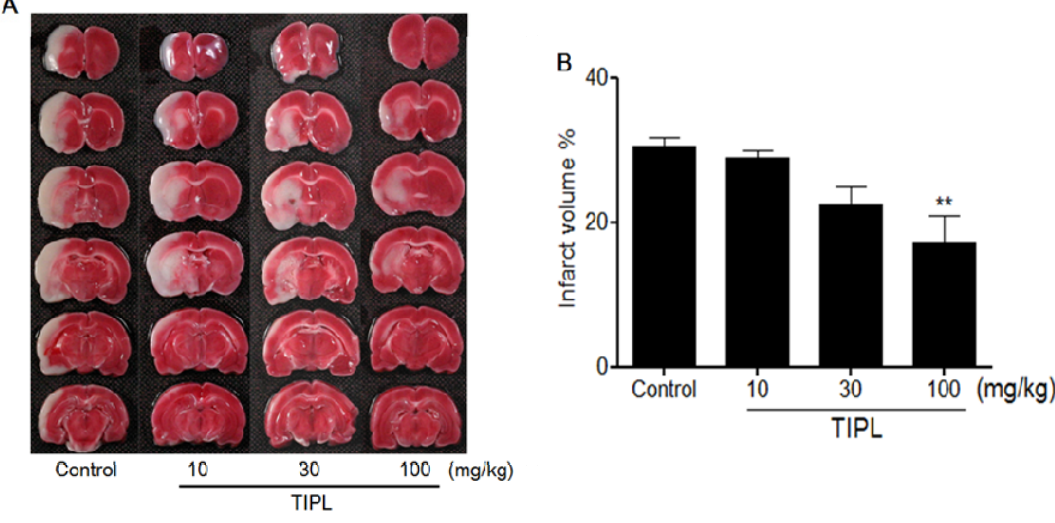
Figure 2. Anti-inflammatory effects of TIPL against ischemic brain injury. The dark pink area indicates the normal area, whereas the white area indicates the infarct area ( A ), and percentage of brain infarct area ( B ). All data are mean ± SD values (n = 10 per group). ** p < 0.01, significantly difference from the control